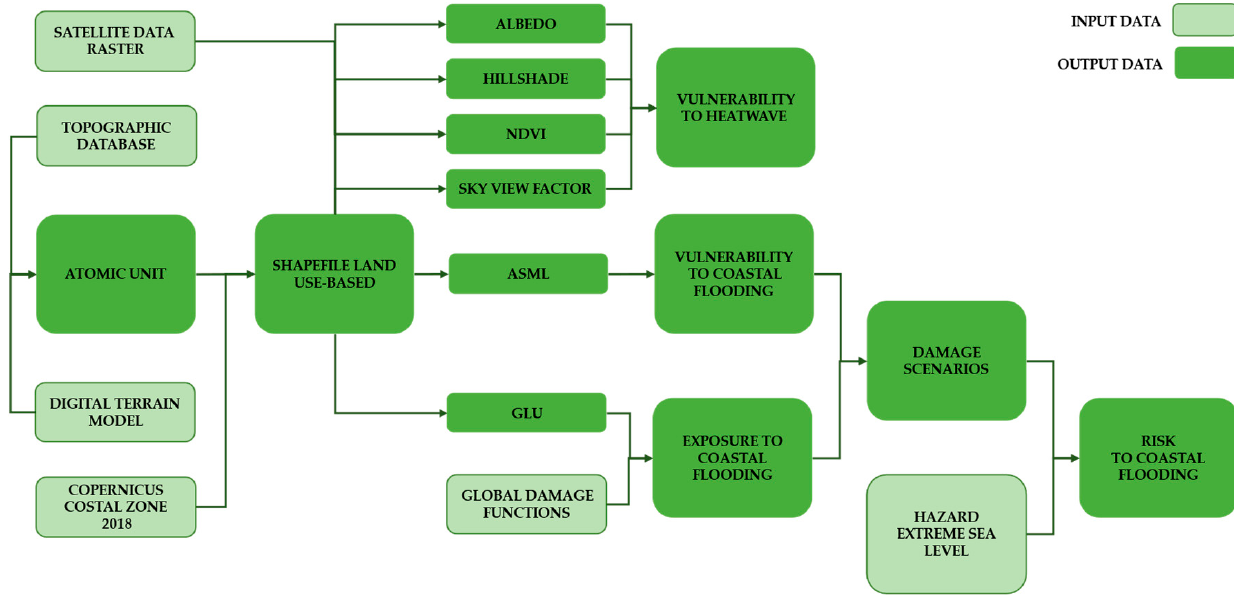
8 of 21 Figure 3. Case study area: Naples waterfront (Italy). In terms of the urban settlement, the area is highly significant for its dense residential and commercial fabric and historical and cultural emergencies; the area is also relevant because of the high number of users (residents and tourists) who live in the public open spaces. Once the case study area was identified, the first step was the input data collection